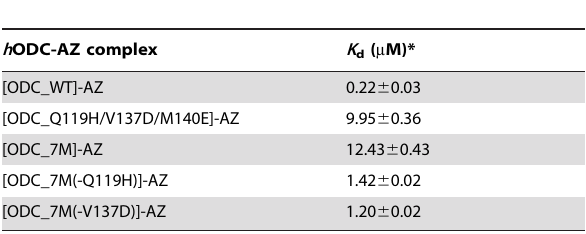
Table 2. Dissociation constants of the human ODC-AZ